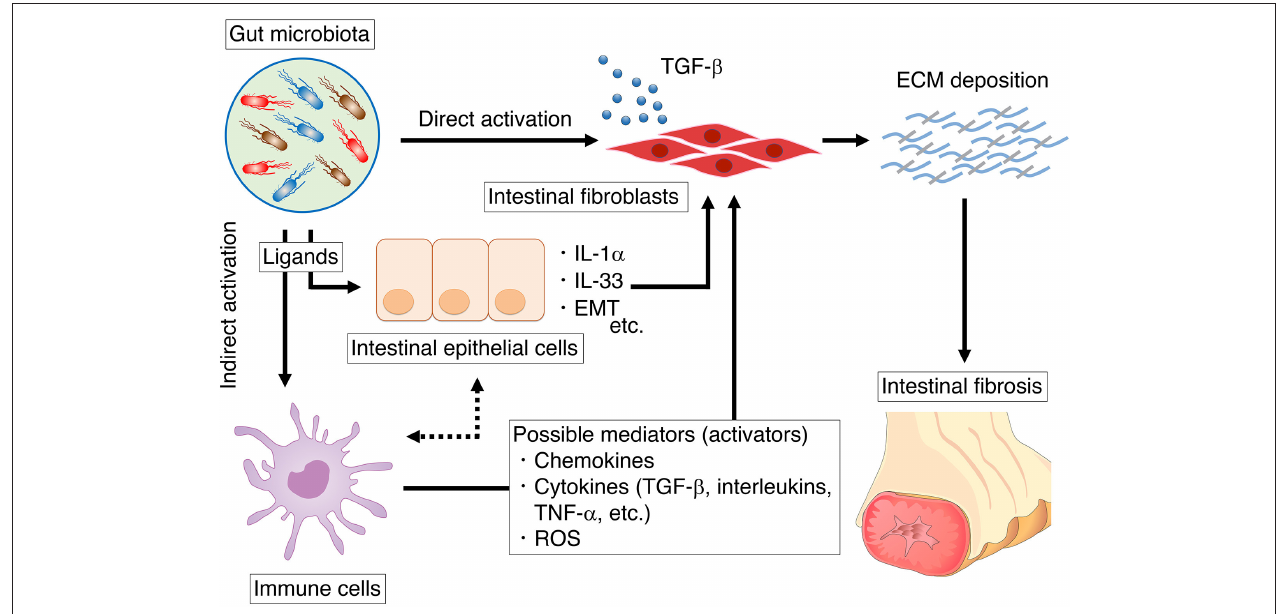
FIGURE 1 | The summary of mechanisms by which the gut microbiota influences intestinal fibroblasts. We summarize the direct influence of microbiota on intestinal fibroblast (section direct activation of fibroblasts through microbial ligands). In addition, we also summarize the indirect influence of microbiota on intestinal fibroblast via epithelial cells or immune cells (section indirect activation of fibroblasts through the microbial ligands).